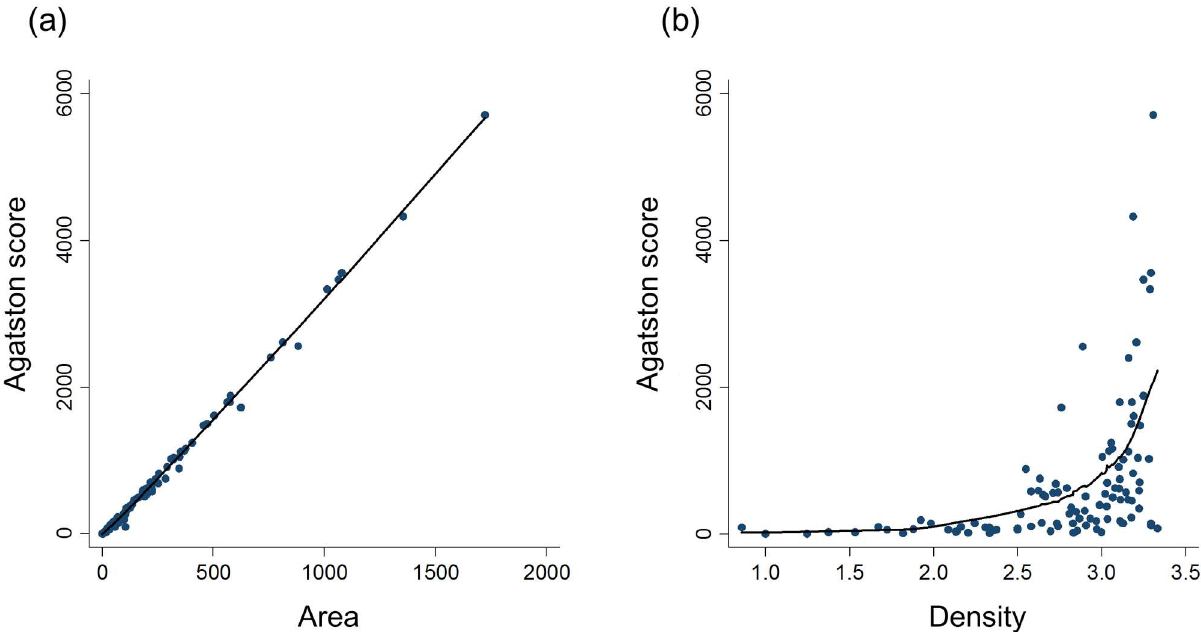
Fig 2. Scatterplots of the Agatston score versus (a) total area and (b) density of coronary artery calcification. R 2 for linear regressionis 0.99 (a) and 0.19 (b), respectively.